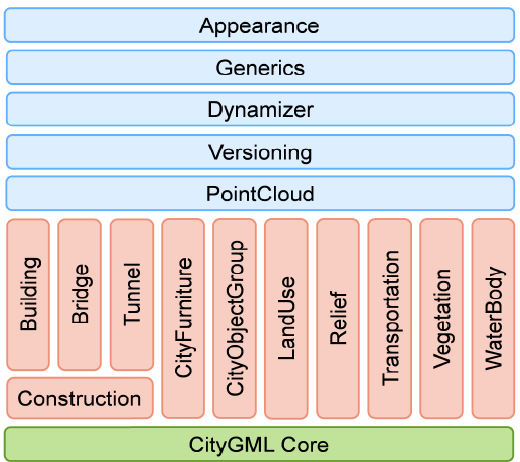
Figure 3 . CityGML 3.0 module overview (Kolbe et al., 2021) CityGML CM most likely needs to be extended to contain attributes that are not explicitly modelled and/or 3D objects which are not covered for specific applications and use